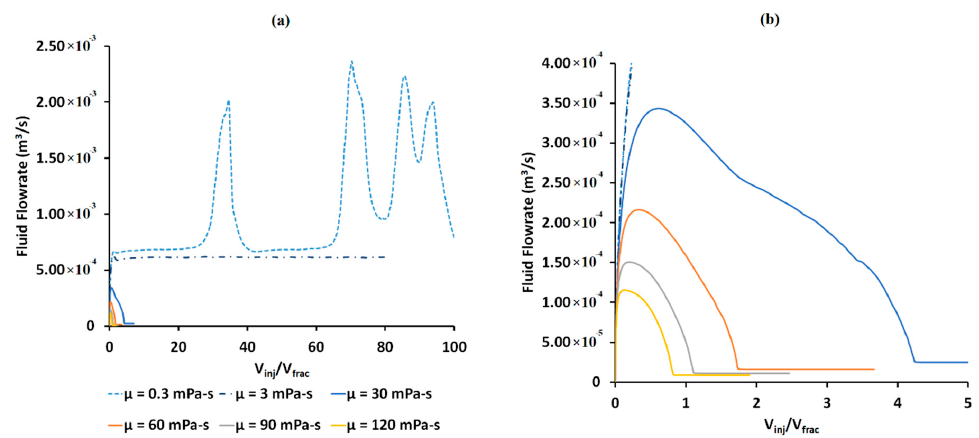
Figure 4. Flowrate at the fracture outlet for fluids with various viscosities. ( a ) Comparison of all six varying cases. ( b ) A closer look at the four most viscous fluids.